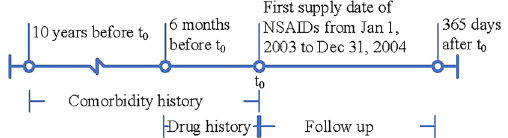
Figure 2. Timeline for study cohort showing history, exposure and follow-up periods. The first supply date for the COX-2 inhibitors or ibuprofen within years 2003 and 2004 was defined as t 0 . The figure was created using